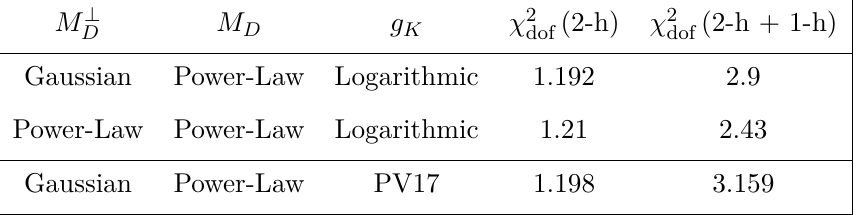
obtained fitting the double hadron production data set only (column Table 1 . Values of the χ 2 dof “2-h”), and those obtained for the combined fit (column “2-h + 1-h”).